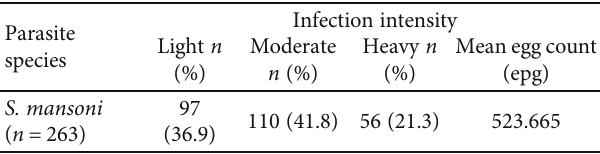
Table 3: S. mansoni infection intensity in schoolchildren in Northwest Ethiopia,